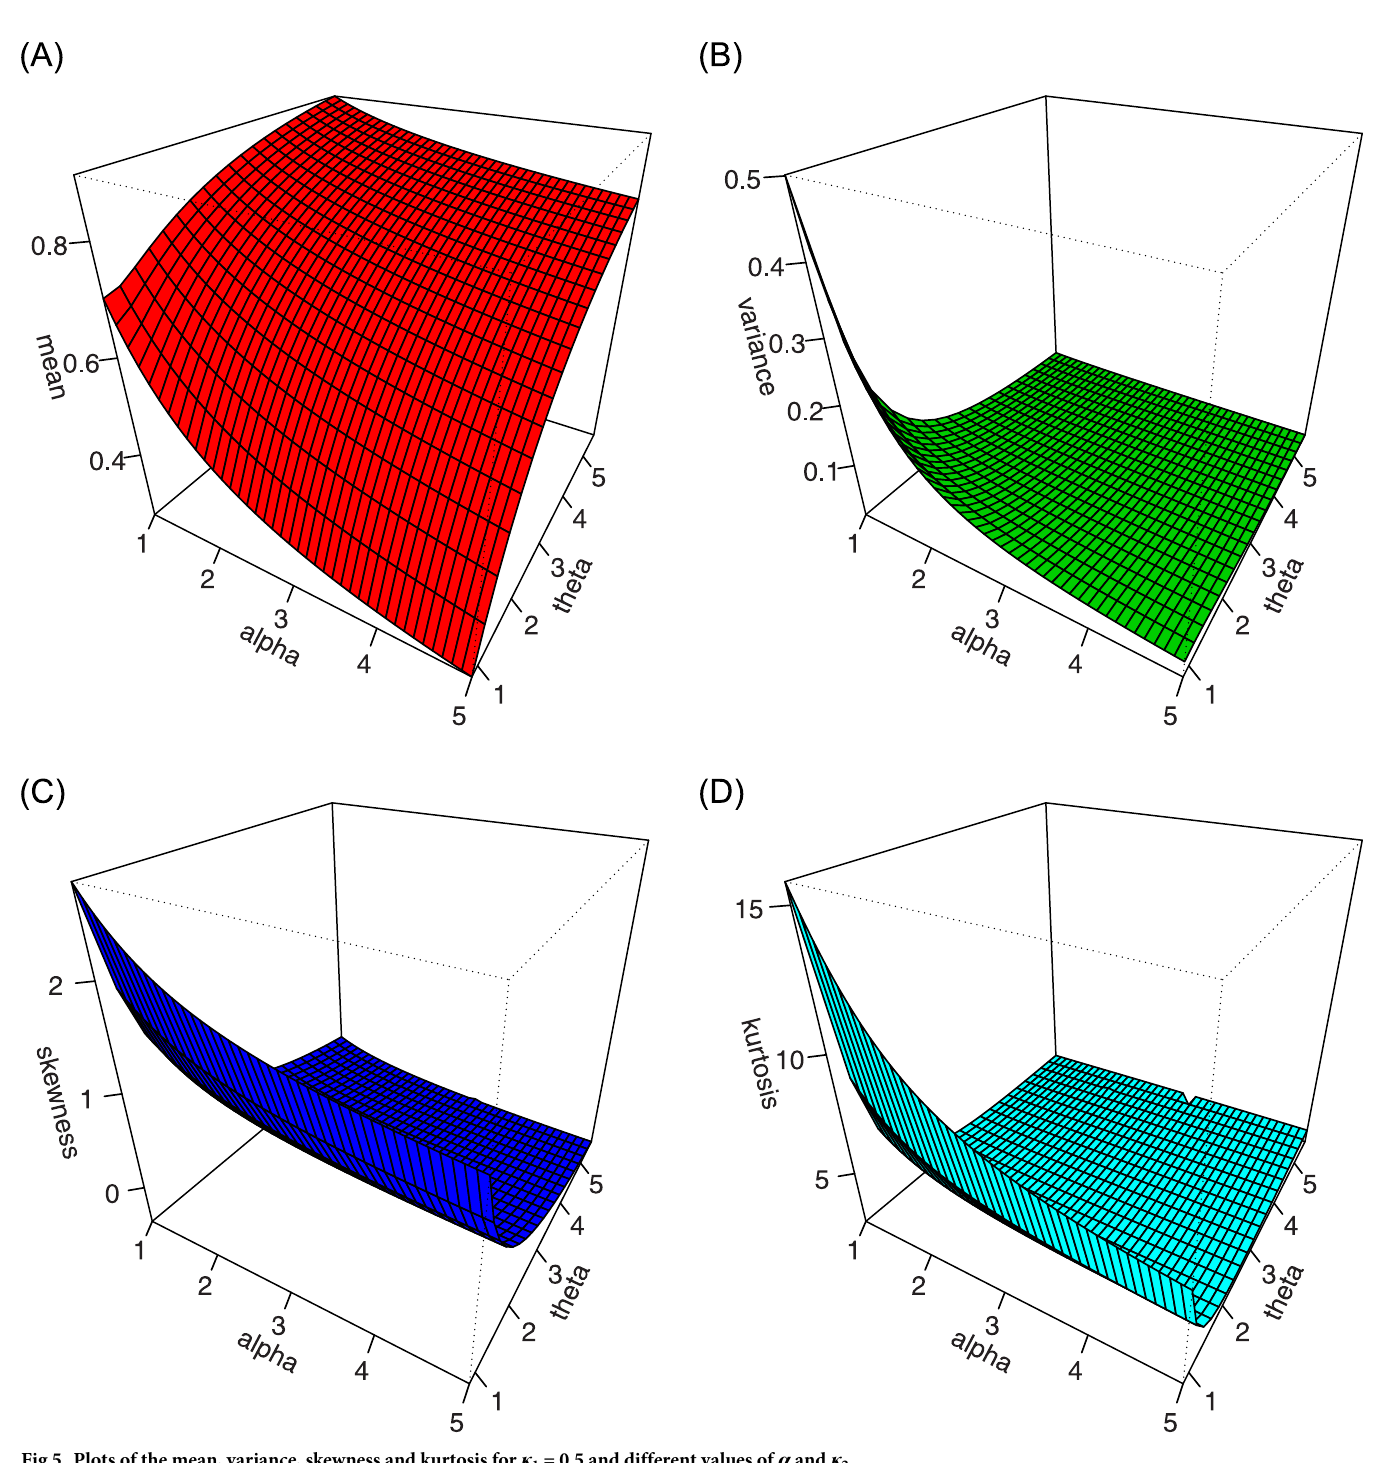
Fig 5. Plots of the mean, variance, skewness and kurtosis for κ 1 = 0.5 and different values of α and κ 2 .